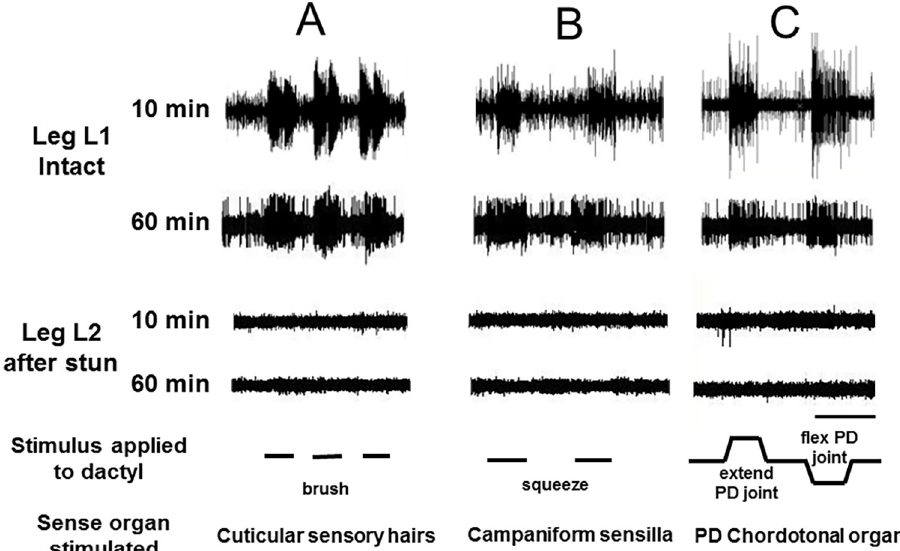
Fig 7. Time course of sensory activity with and without electrical stunning. Responses of sensory neurones in the leg nerve of the crab C . pagurus to three forms of stimulation of the dactylopodite (A-C) as indicated, measured at 10 min and 60 min after leg isolation. Top panels, leg L1 autotomised from intact animal; lower two panels, leg L2 amputated from the same animal after electrical stunning. Scale bar 5